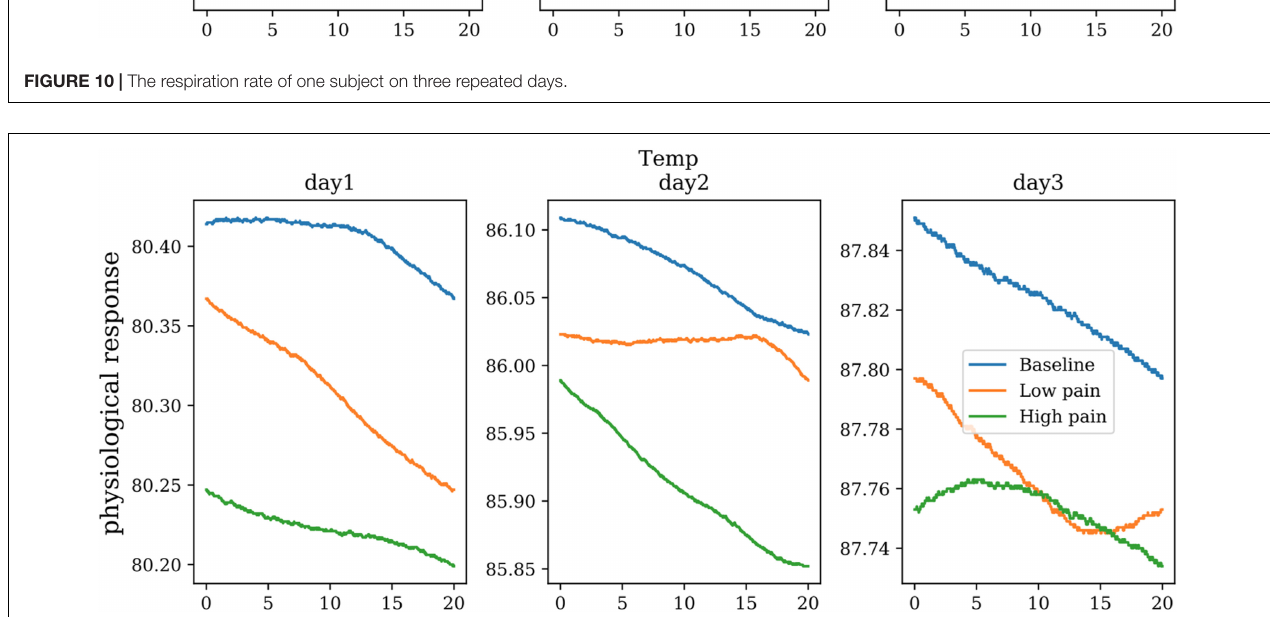
FIGURE 11 | The skin temperature of one subject on three repeated